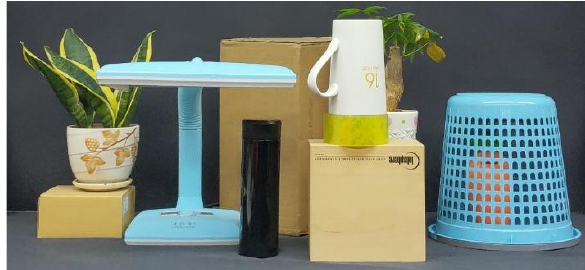
Figure 2. Experimental scene containing 14 materials After the scanning of the experimental scene, the multispectral lidar point cloud is obtained as shown in Figure 3. The size is about 1.01 × 0.51 × 0.35 m, and 6684 points were produced. We conducted the reference target-based radiometric calibration to obtain the precise spectral information of every point. The effects of detection distance and beam incidence angle on spectral intensities are calibrated through it.